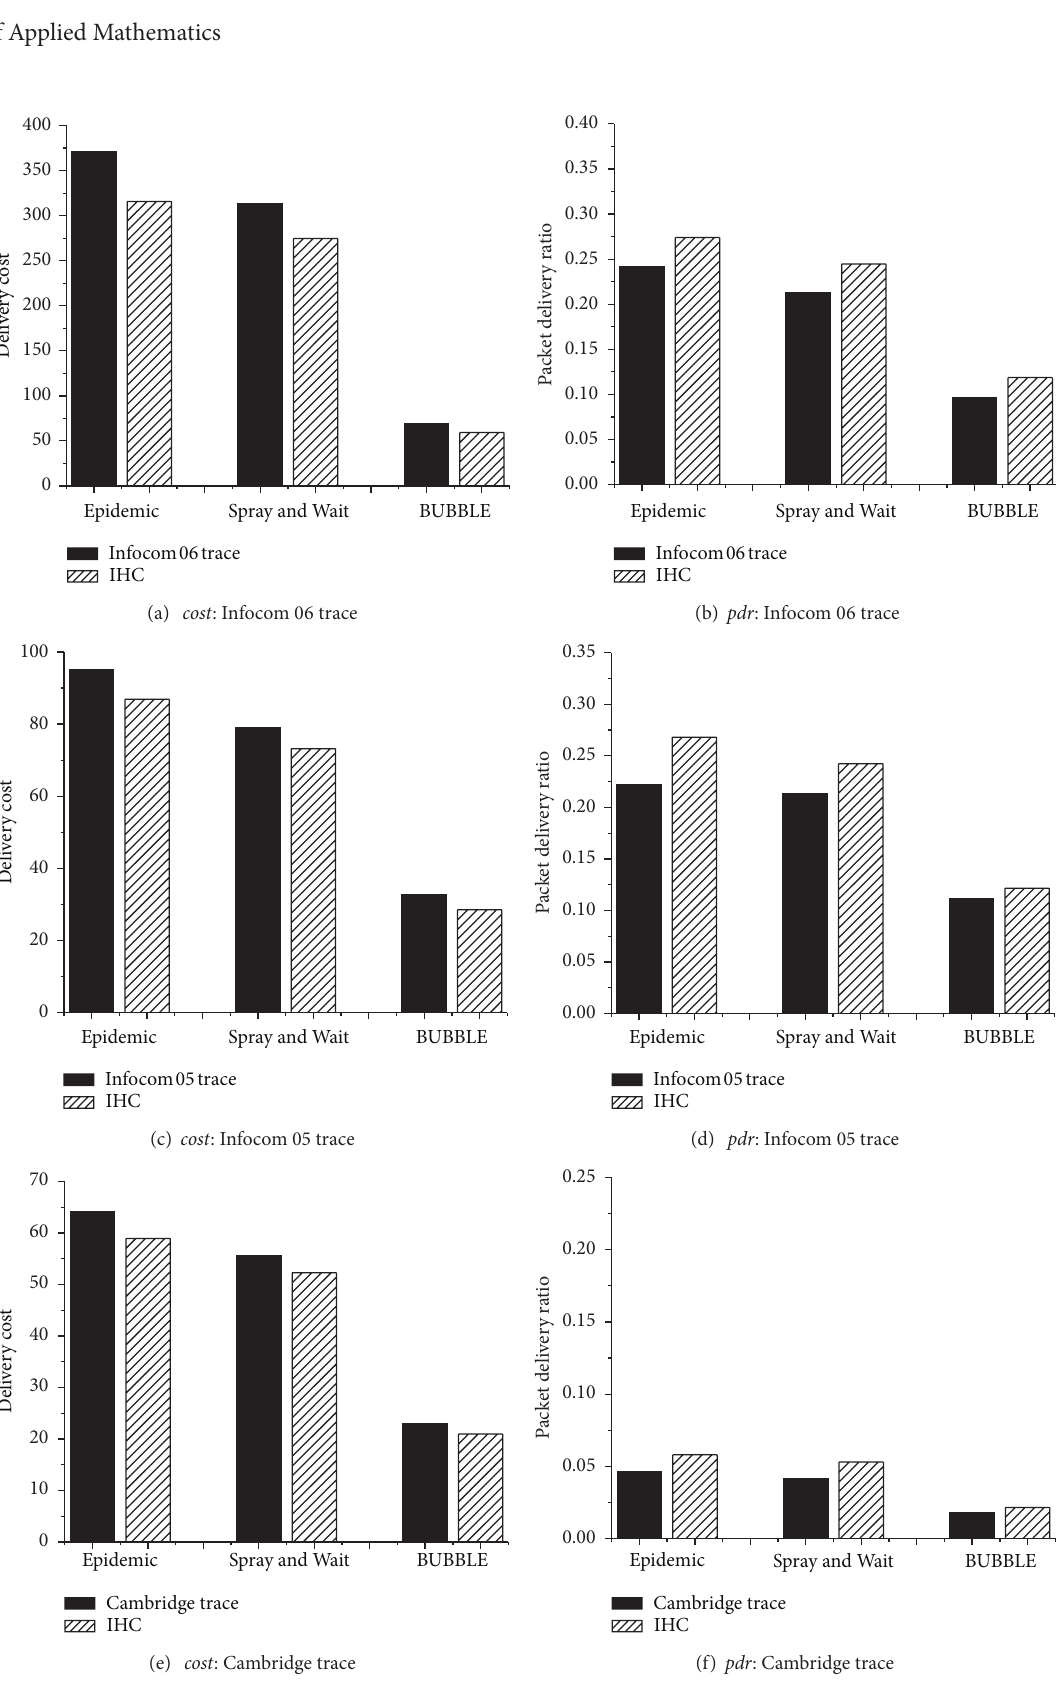
Figure 11: Performance of forwarding protocols (interest vectors change with the alternate